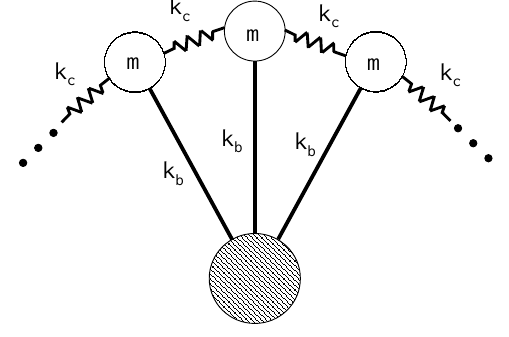
Fig. 2. Coupled oscillator